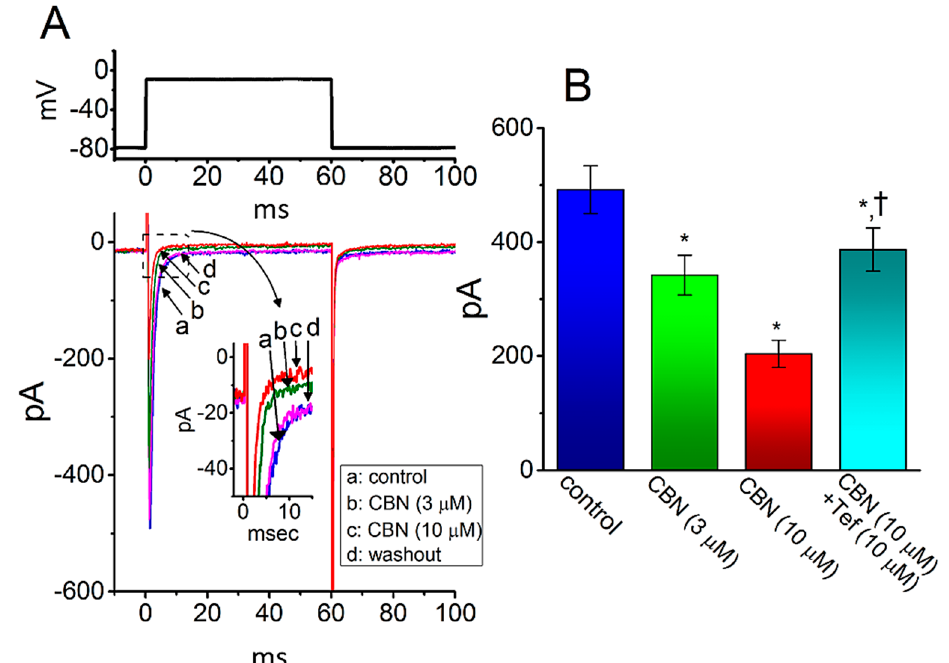
Figure 9. Effect of CBN on the amplitude of I Na recorded from HL-1 atrial cardiomyocytes. The whole-cell current recordings were conducted in cells, which were bathed in Ca 2+ -free, Tyrode’s solution, and we backfilled the electrode with Cs + -containing solution. ( A ) Representative current traces activated by 60-ms depolarizing pulse from − 80 to − 10 mV (indicated in the upper part). a: control (i.e., CBN was not present), b: 3 µ M CBN, c: 10 µ M CBN, and d: washout of the agent. Inset in ( A ) indicates the expanded record from dashed box. ( B ) Summary bar graph demonstrating effect of CBN and CBN plus tefluthrin (Tef) on the peak amplitude of I Na in HL-1 cells (mean ± SEM; n = 8 for each bar). Current amplitude was taken at the start of depolarizing pulse from − 80 to − 10 mV. * indicates significantly different from control ( p < 0.05) and † indicates significantly different from CBN (10 µ M) alone group ( p < 0.05).